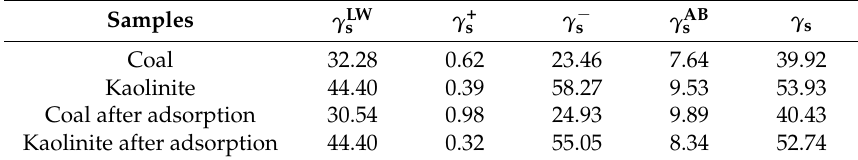
Table 3. Surface free energy components of kaolinite and coal with the effect of PAM A401 (at 20 ◦ C). Samples γ LW s γ + s γ − s γ AB s γ s Coal